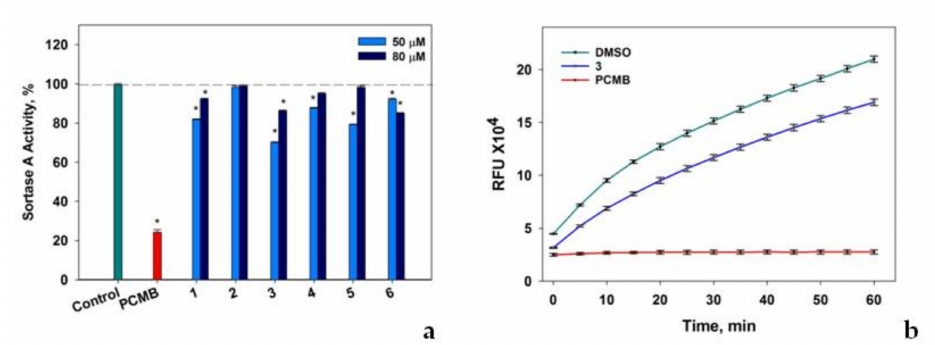
Figure 6. The effect of compounds 1 – 6 on sortase A enzymatic activity. ( a ) The effect of compounds 1 – 6 on sortase A enzymatic activity measured after 10 min of incubation with the substrate. ( b ) The time-dependent effect of compound 3 (50 µ M) on sortase A enzymatic activity. Data presented as relative fluorescent units (RFU). DMSO (0.8%) did not show any inhibition activity in comparison with sortase A assay buffer and was used as a control. The sortase inhibitor—4-(hydroxymercuri)benzoic acid (PCMB) in DMSO 0.8% was used as a positive control. All experiments were performed in three independent replicates and the data presented as a mean ± standard error mean (SEM). * indicates the significant differences with p ≤